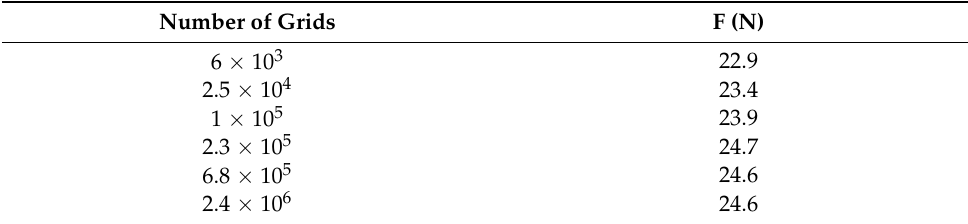
Table 3. Effect of grid numbers on predicted force.